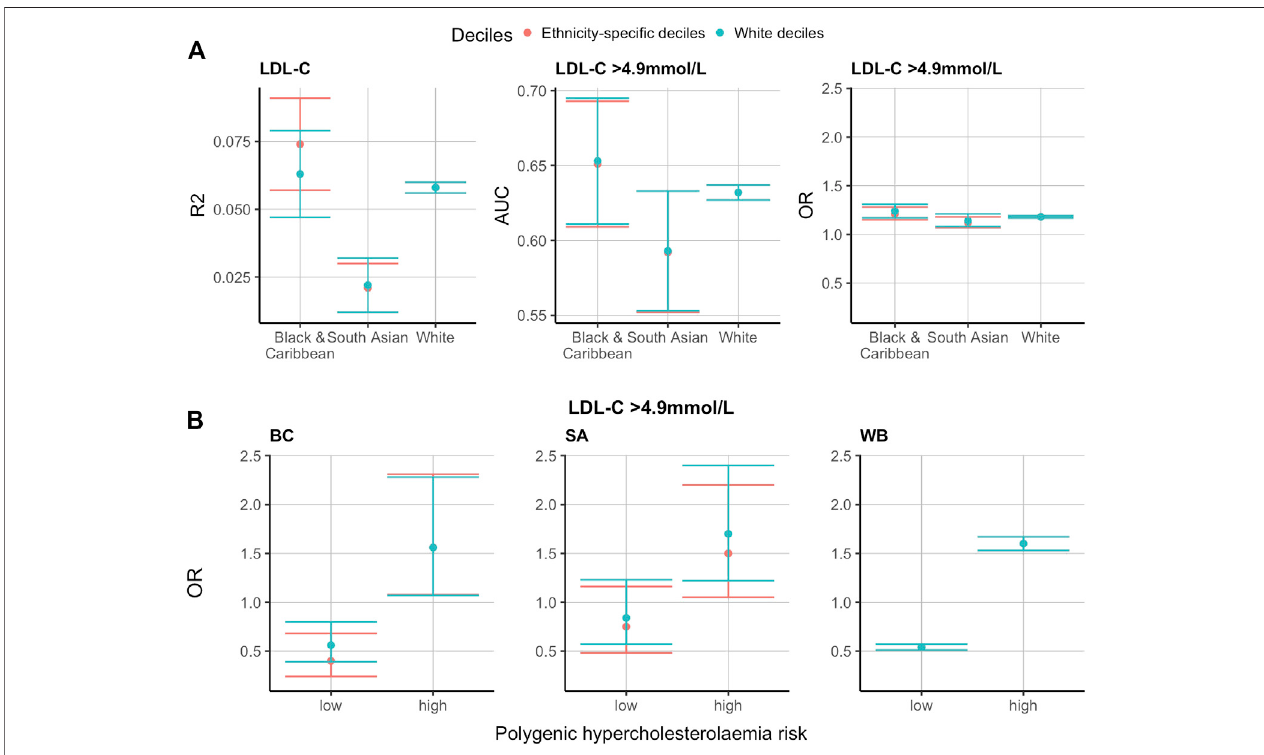
FIGURE 3 | Ethnicity-speci fi c versus WB 12-SNP score decile cut-off values in the prediction of LDL-C and hypercholesterolaemia (LDL-C > 4.9 mmol/L) in self- reported BC, SA and WB ethnicities. The results presented here are using the test data. The training data was used to obtain the 12-SNP score decile cut-off values for each ethnic group studied. The red and blue plots refer to ethnicity-speci fi c and White deciles respectively. (A). R 2 , AUC and OR for the prediction of LDL-C and hypercholesterolaemia (LDL-C > 4.9 mmol/L) using ethnicity-speci fi c versus WB 12-SNP score decile cut-off values. (B) . Polygenic hypercholesterolaemia risk using ethnicity-speci fi c versus WB 12-SNP score deciles cut-off values for the prediction of hypercholesterolaemia (LDL-C > 4.9 mmol/L). Low polygenic hypercholesterolaemia risk refers to the 12-SNP score deciles 1-3, intermediate polygenic hypercholesterolaemia risk represent deciles 4-5, and high polygenic hypercholesterolaemia risk are for deciles 6 – 10. Intermediate polygenic hypercholesterolaemia risk is the reference group equal to an OR of 1. LDL-C, low-density lipoprotein cholesterol; R2, correlation coef fi cient ( R 2 ); OR, odds ratio; AUC, area under the curve; BC, Black & Caribbean; SA, South Asian; WB, White